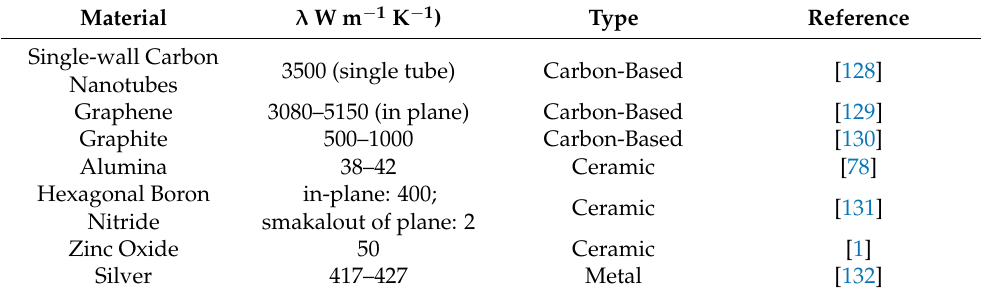
Table 1. Thermal conductivities of the carbonaceous and ceramic fillers considered in this review.